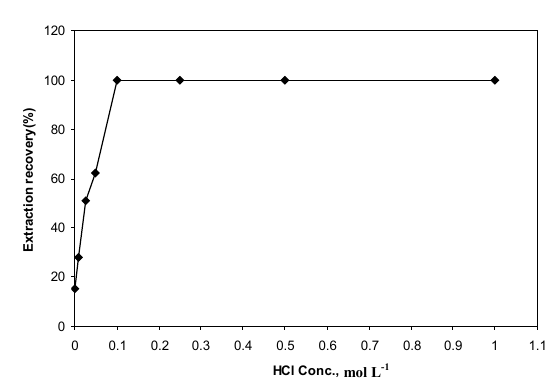
Figure. 1. Effect of HCl concentration on the extraction recovery of Au (100 ng mL -1 ). 5×10 -6 mol L -1 brilliant green, 0.05% (v/v) Triton